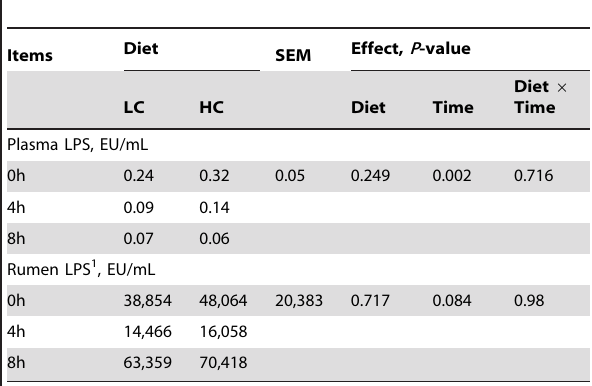
Table 3. Lipopolysaccharide (LPS) levels in plasma and in rumen fluid of control and treatment group goats.